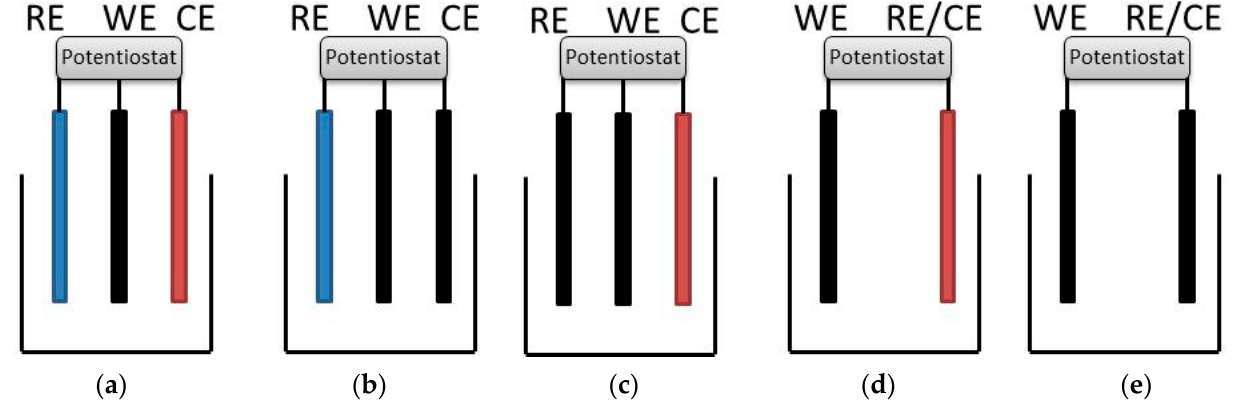
Figure 1. Varying electrode configurations used to assess impact on electrochemical response as defined in the experimental section. Black—0.6 mm diameter platinum disc, Red—1 cm 2 platinum mesh, Blue—Ag|AgCl (3 M